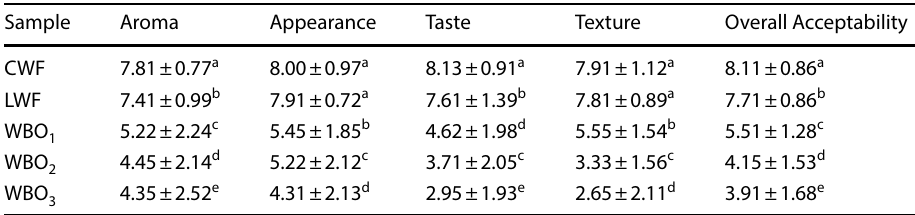
Means ( ± SD) with different alphabetical superscripts in the same row are significantly different at P < 0.05. [75% wheat, and 25% bambara groundnut